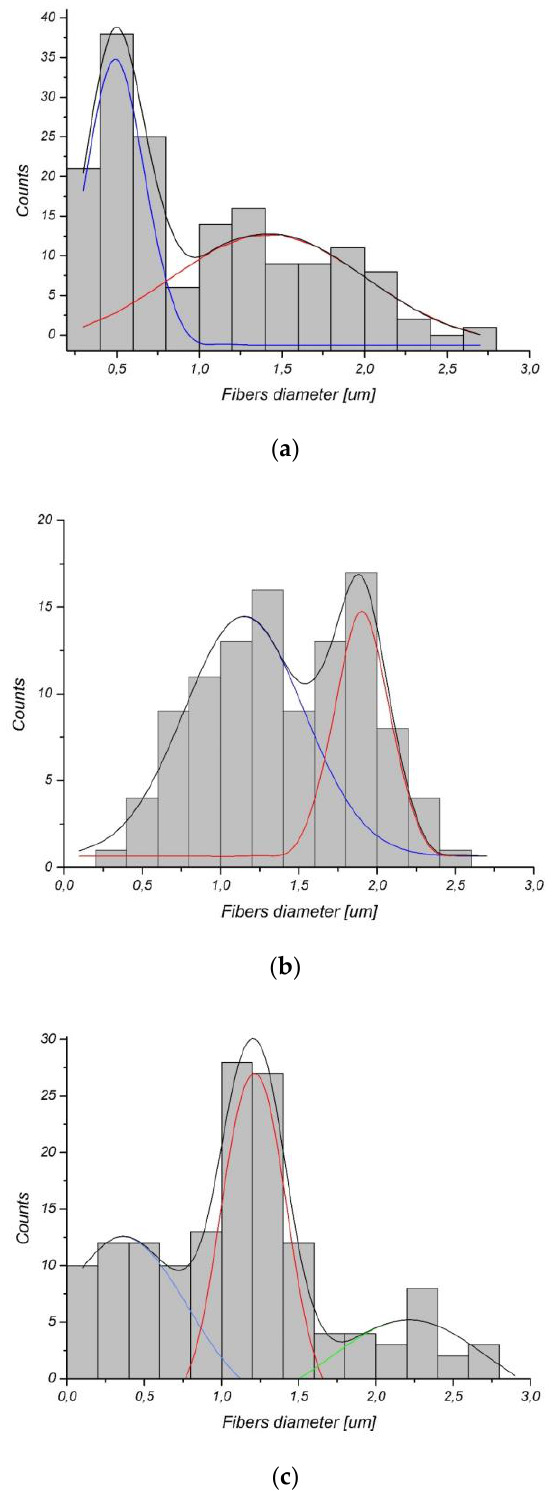
Figure 2. Fiber diameter histograms of ( a ) PCL, ( b ) PLCL, ( c ) PLLA.